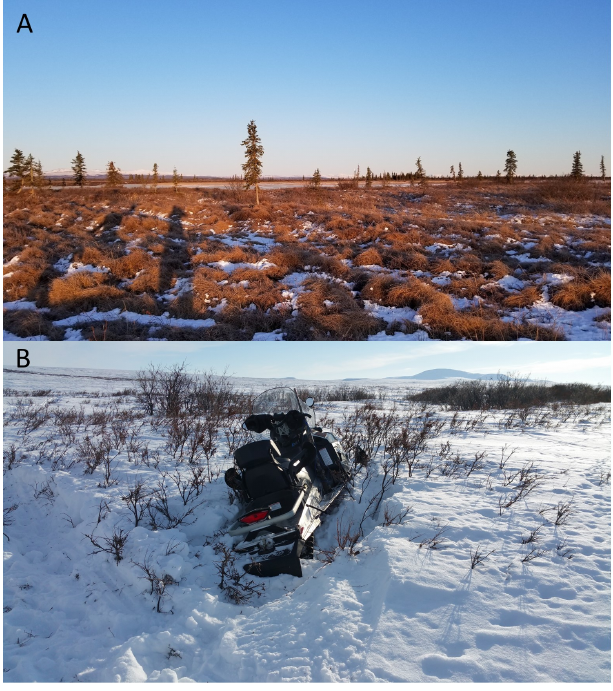
Fig. 3 . Environmental challenges faced by residents in rural Alaska: (A) no snow in Noatak in November 2019; (B) deep snow within shrubs outside of Noatak March